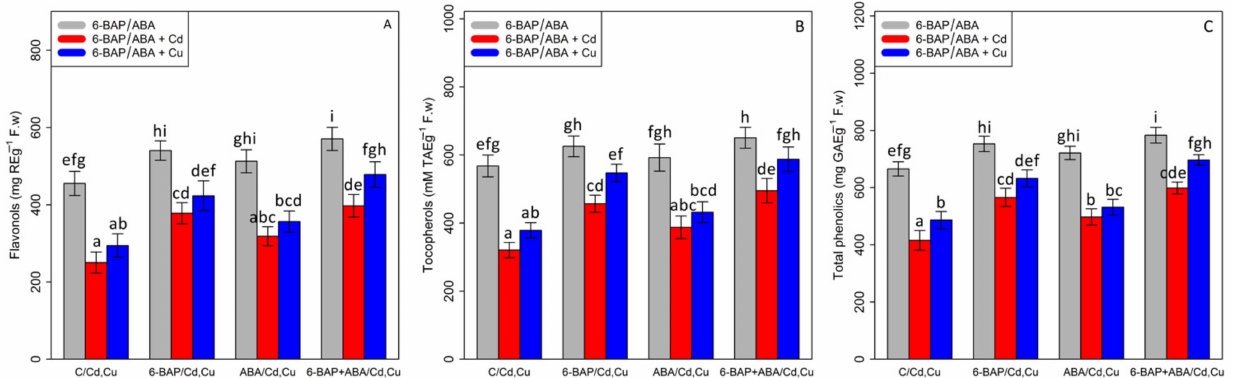
Figure 6. The effect of 6-benzylaminopurine and abscisic acid, single and in combination, on non- antioxidant enzyme activities (Flavonol ( A ), Tocopherol ( B ), and total phenolics ( C )) in one-year-old Pleioblastus pygmaeus expose to 100 µ M Cd and 100 µ M Cu. In this figure, a, b, c, etc. letters reveal significant differences between control, 6-BAP, ABA and co-application of 6-BAP + ABA in both combined and single form with 100 µ M cadmium and 100 µ M copper base on Tukey’s test ( p < 0.05).